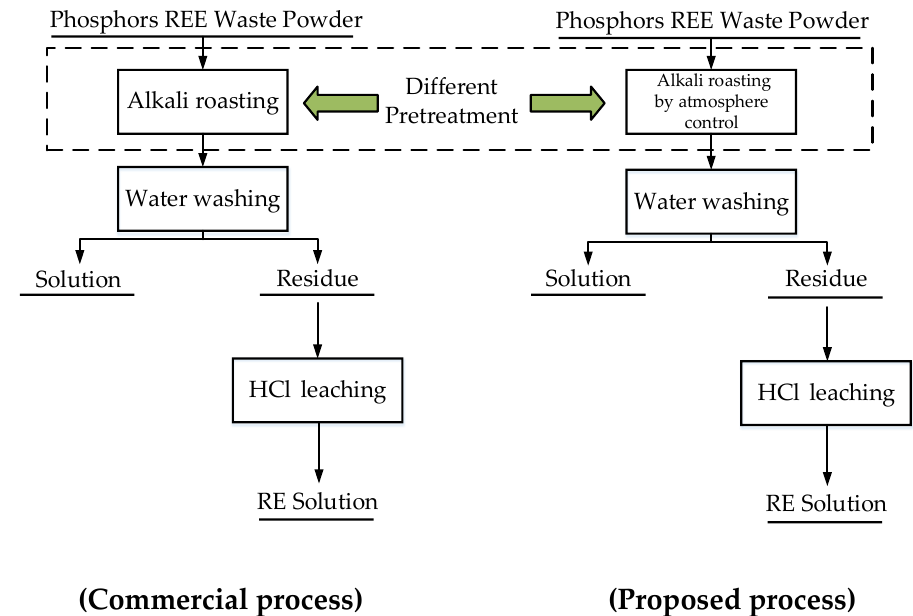
Figure 5. XRD pattern of the water-washing residue of the roasting product under the condition of 0.5% oxygen concentration.